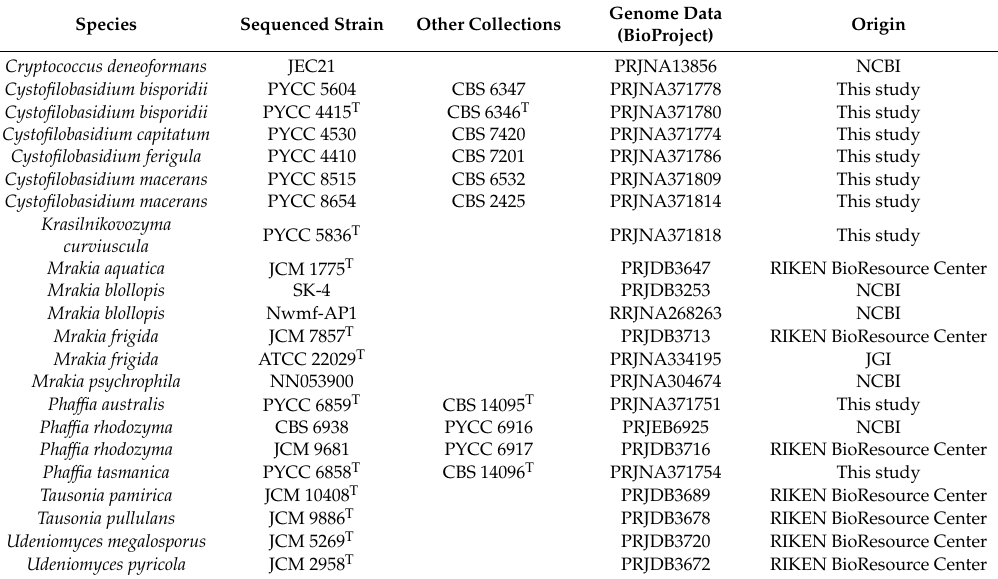
Table 1. List of draft genomes and correspondent cultures used in this